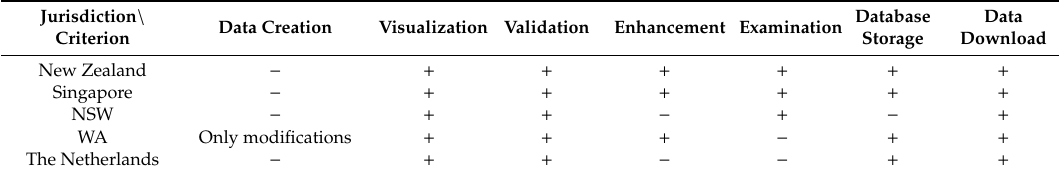
Table 2. Cross-jurisdictional comparison of land registry services required for supporting digital lodgment of cadastral data, + : Supported, − : Not